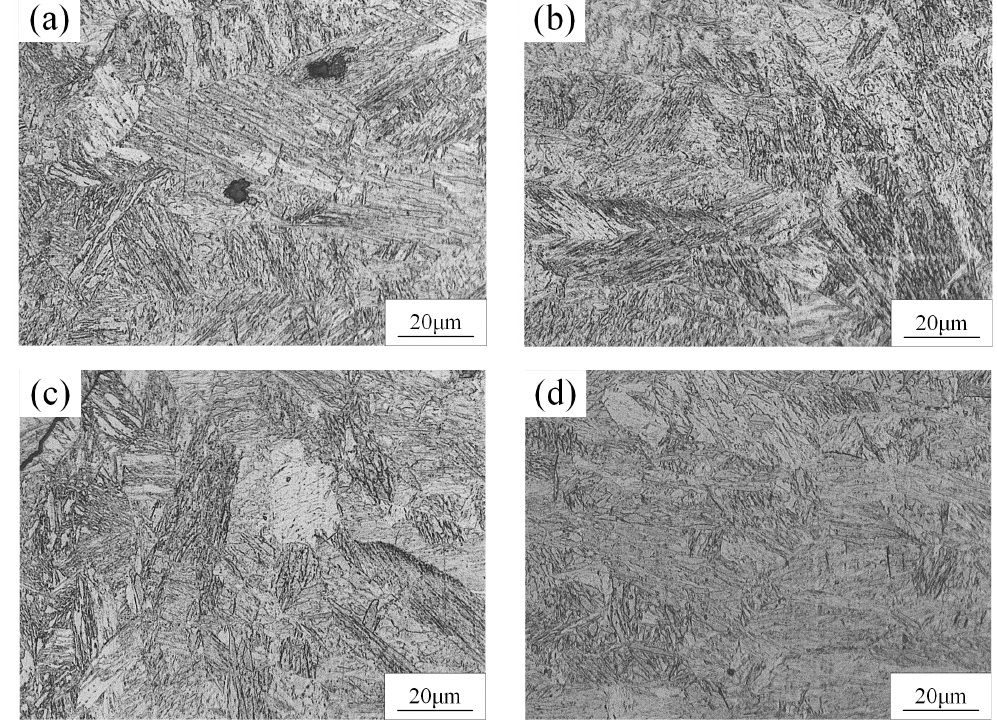
Figure 7. The microstructure of FZ of DP 780 laser-welded joint under different welding speeds (mm/s): ( a ) 30, ( b ) 40, ( c ) 50, and ( d )